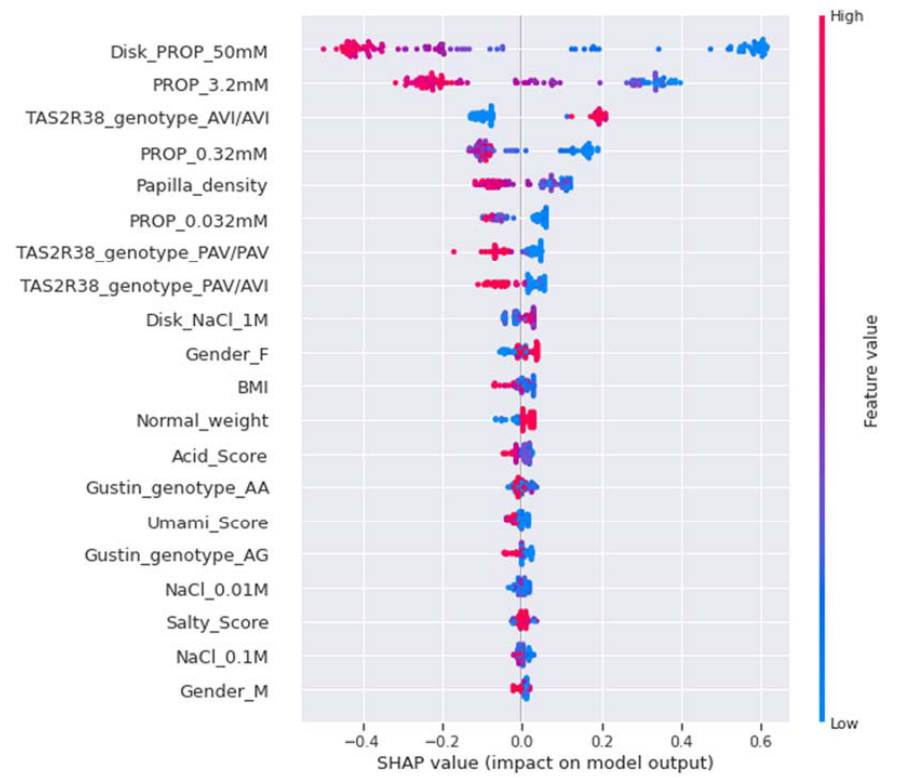
Figure 8. SHAP summary plot of the NT category. The left ‐ hand side of the Y ‐ axis represents the descending order of importance of the NT category features; the X ‐ axis represents the impact of the SHAP value on the output model. The color represents the feature value: high values have a pink color, while low values have a blue one.